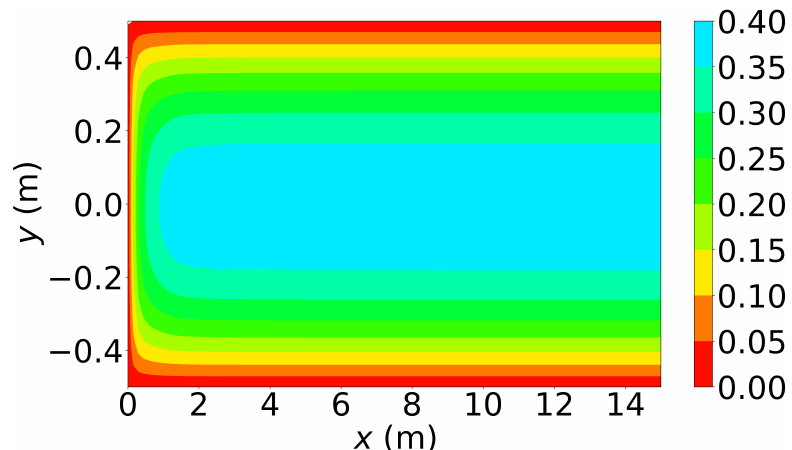
Figure 6. u -velocity in meters per second at 0.01 s.